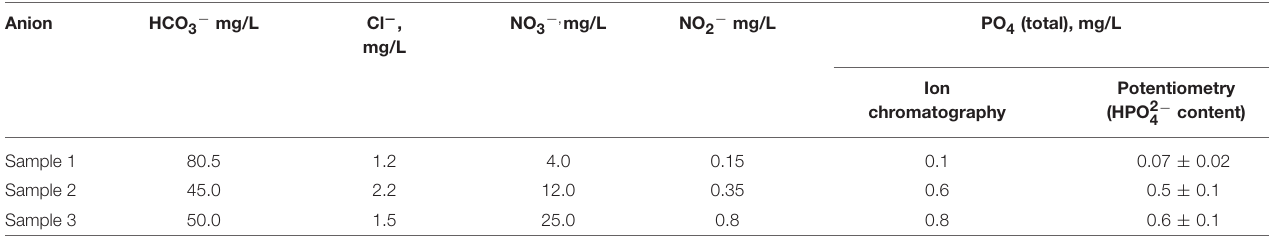
TABLE 5 | Phosphate determination in lake water samples with the potentiometric sensor based on CB/IL 1